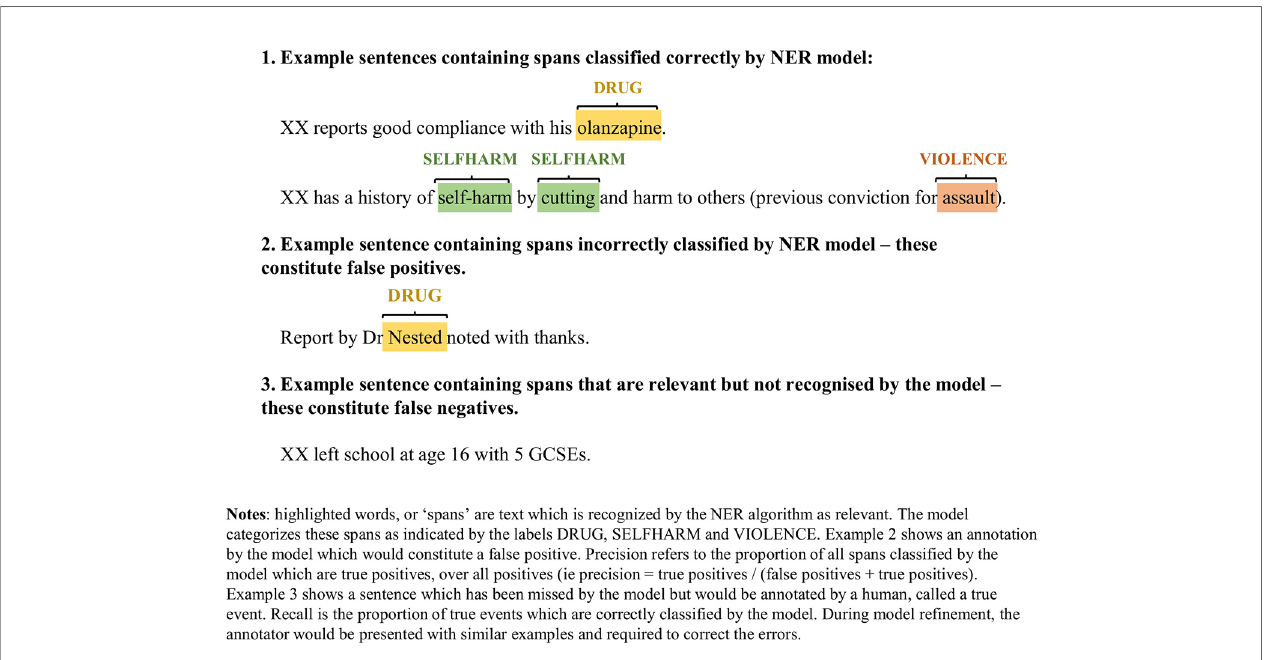
FIGURE 1 | Illustrative examples of sentence classi fi cation by named entity recognition